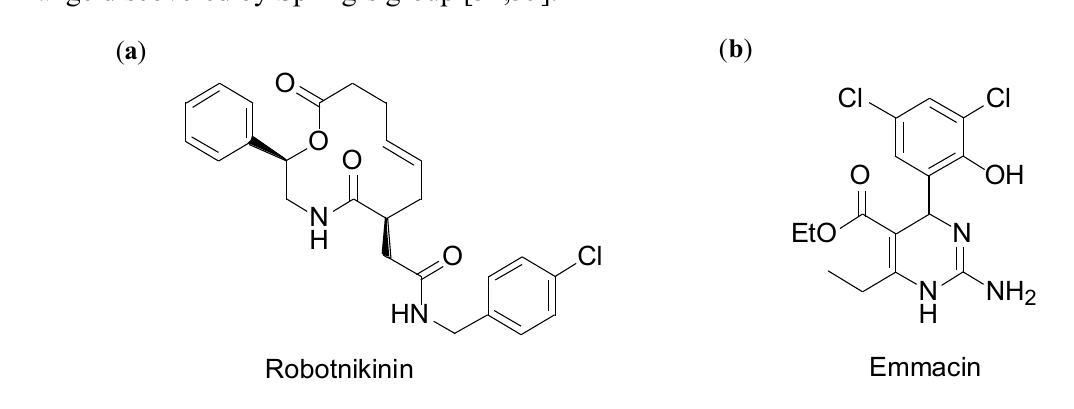
Figure 3. ( a ) Robotnikinin, a low µM sonic hedgehog inhibitor discovered by Schreiber’s group [33]; ( b ) Emmacin, a potent antibacterial compound with MIC 50 on the low